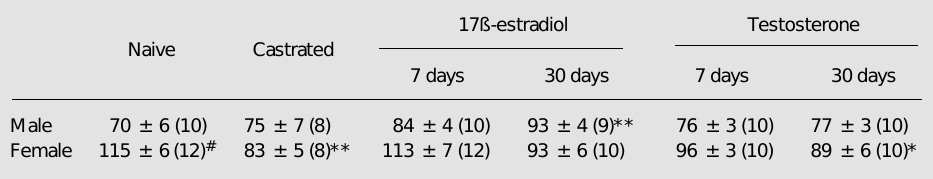
Table 1. Baseline values of coronary perfusion pressure (mmHg) in isolated hearts from the following groups of male and female rats: naive, castrated, and castrated and long-term treated with 17ß-estradiol or testoster- one for 7 and 30